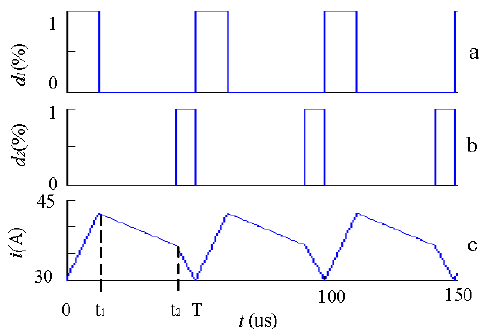
Figure 7. The PWM and current of the circuit at one